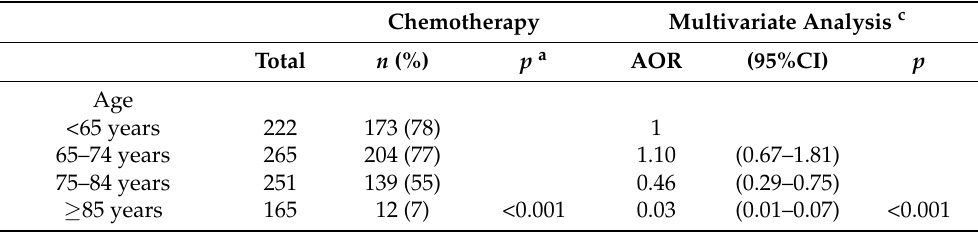
Table 3. Administration of chemotherapy in patients with pancreatic cancer ( n =